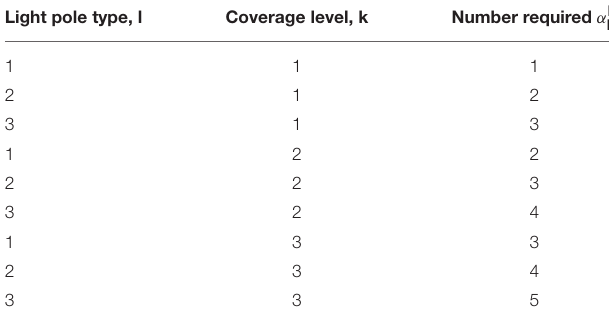
TABLE 1 | Number of light poles required.